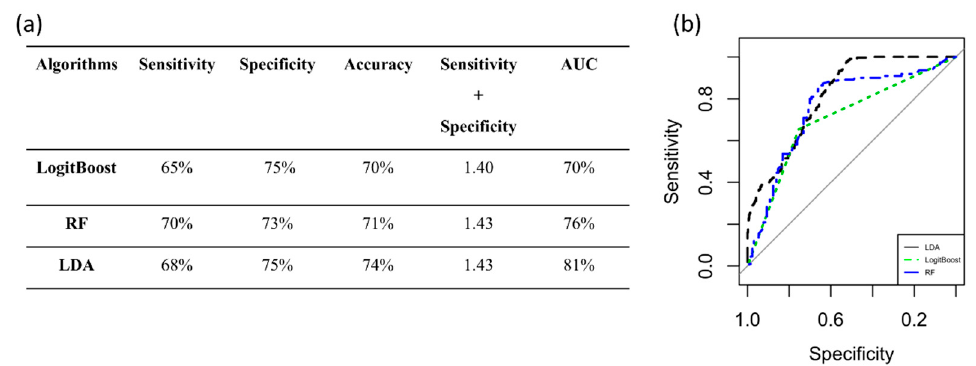
Figure 7. Performance measures to classify high and low values of Ki-67. ( a ) Algorithm performance via PC3 to classify high and low values of Ki-67. ( b ) ROC curves of the three classifiers. AUC: area under the curve; RF: random forest; LDA: linear discriminant analysis.